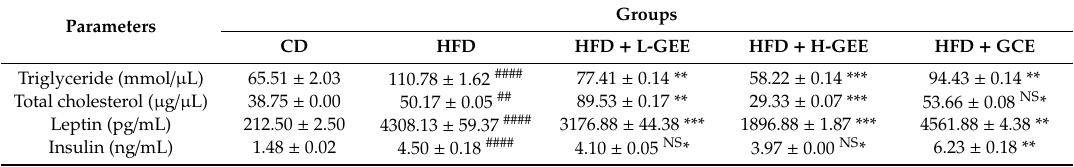
Table 1. E ff ect of GEE on mouse blood serum biochemistry in HFD-induced obese mice. Groups Parameters CD HFD HFD + L-GEE HFD + H-GEE HFD + GCE Triglyceride (mmol / µ L) 65.51 ± 2.03 110.78 ± 1.62